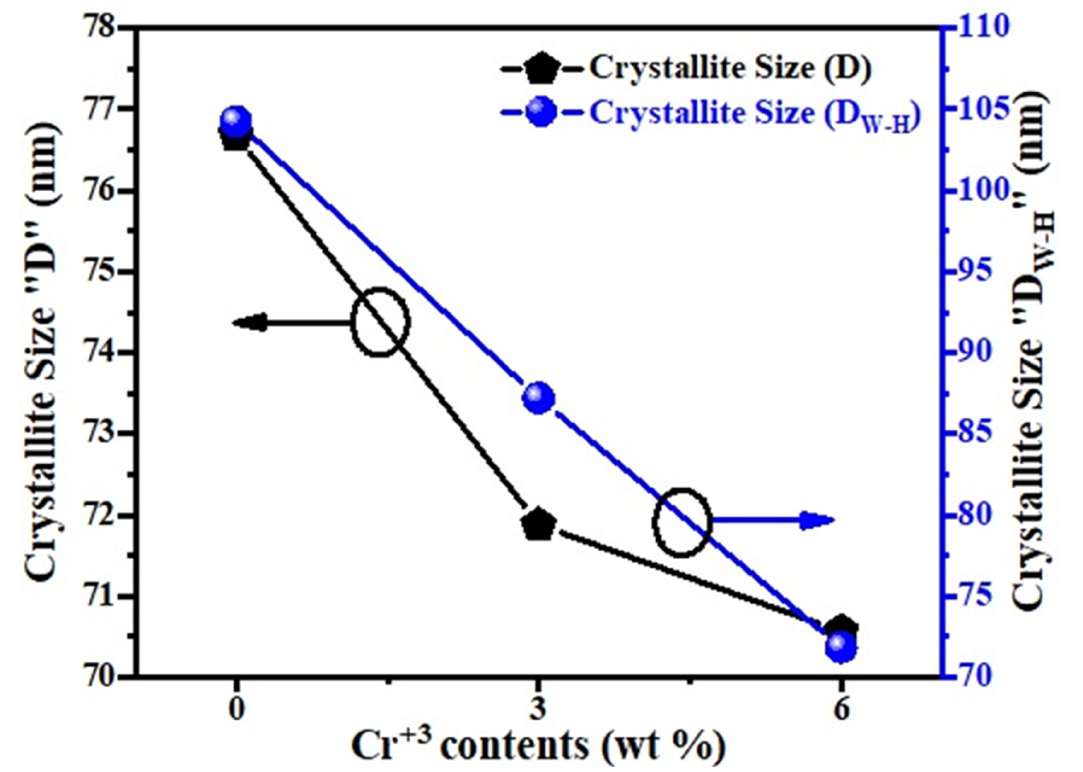
Figure 2. Plot of average crystallite size ( D and D W-H ) of un-doped and Cr-doped MoO 3 (3 wt% and 6 wt%). 6